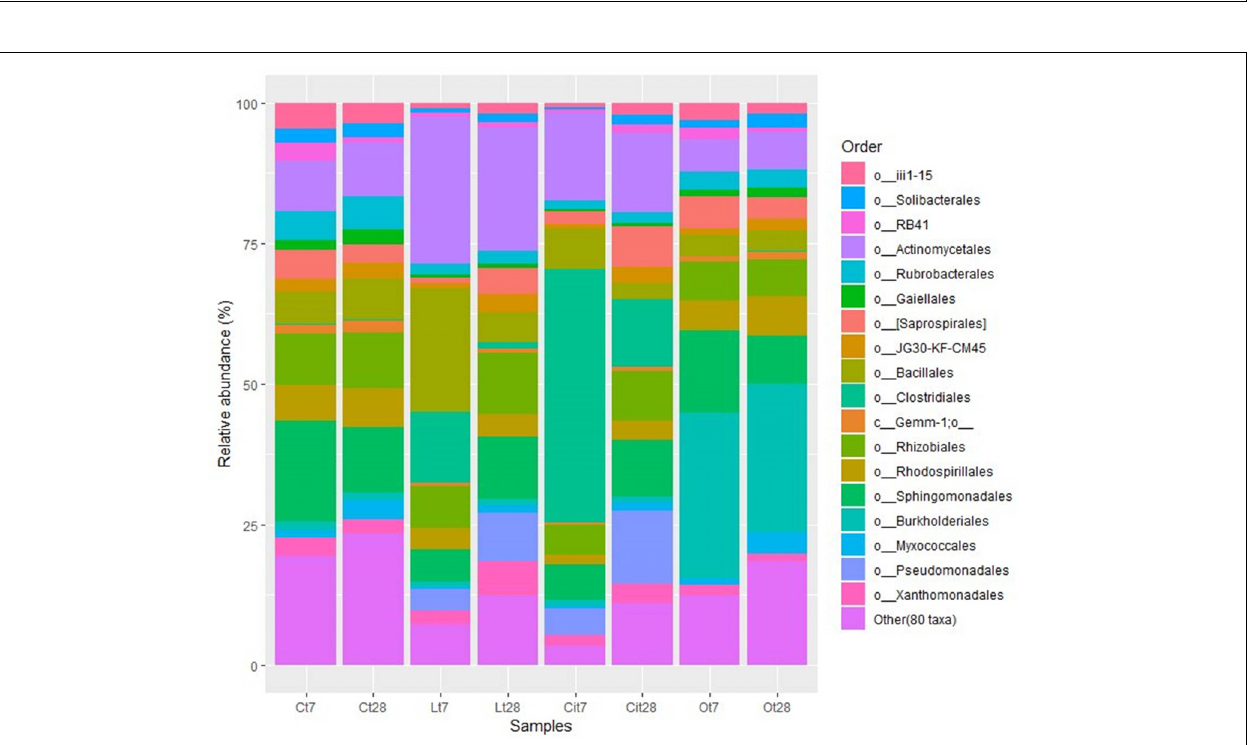
FIGURE 8 | Major bacterial orders. Orders with a total abundance of less 1.0% were collected into “Other (80 taxa).” C, control sample; L, lactic acid treated sample; O, oxalic acid treated sample; Ci, citric acid treated sample. t7: day 7; t8: day 28.